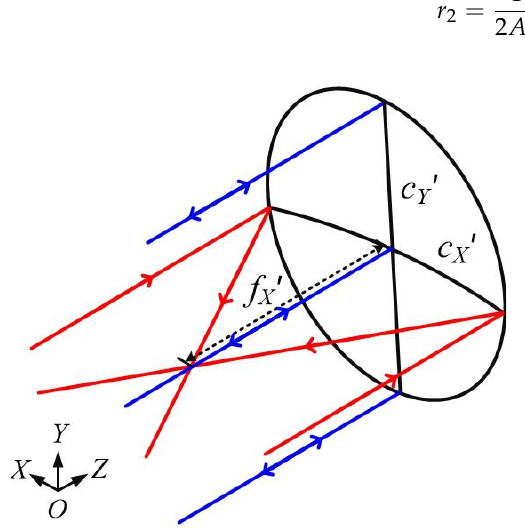
Figure 3. Surface map of the A 3 x 2 term.